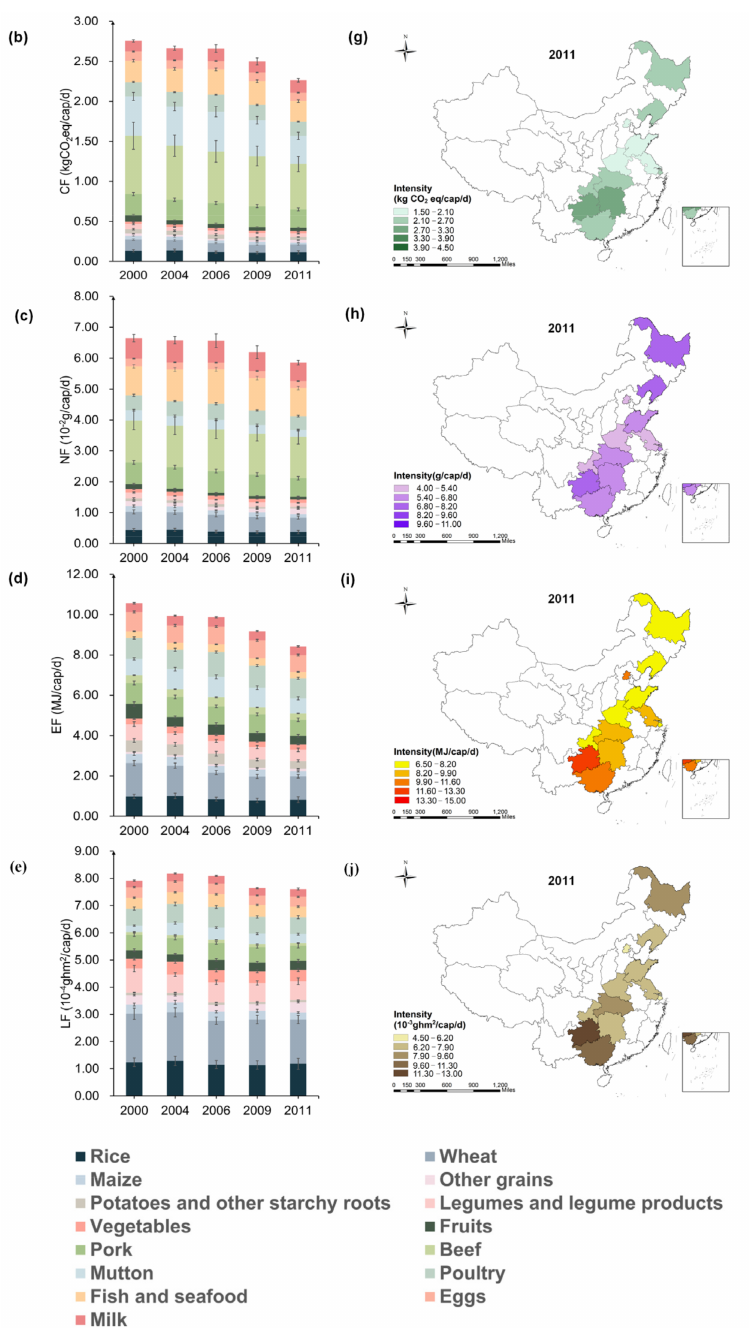
Figure 3. Spatial-temporal characteristics of dietary footprints of Chinese household (( a , f ): WF; ( b , g ): CF; ( c , h ): NF; ( d , i ): EF; ( e , j ): LF; The error lines in the figure are standard errors). This study also considered the differences among 12 provinces during the year of 2011. Whereas the WF of Henan households was observed to be the lowest (2.97 m 3 /cap/d), Guizhou was the highest (5.33 m 3 /cap/d), 1.79-fold higher than Henan. The EF of Chongqing household was recorded as the lowest (6.83 MJ/cap/d), while Guizhou was found highest (11.69 MJ/cap/d), 1.71-fold higher than Chongqing. Further- more, the dietary CF and NF of Beijing households was the lowest, reached 1.85 kgCO eq/cap/d and 4.35 × 10 − 2 g/cap/d. However, the CF of Guizhou was the high- 2 est (3.19 kgCO eq/cap/d), 1.72-fold higher than Beijing. The NF of Guizhou household 2 was the highest (7.90 × 10 − 2 g/cap/d), 1.82-fold higher than Beijing. The LF of